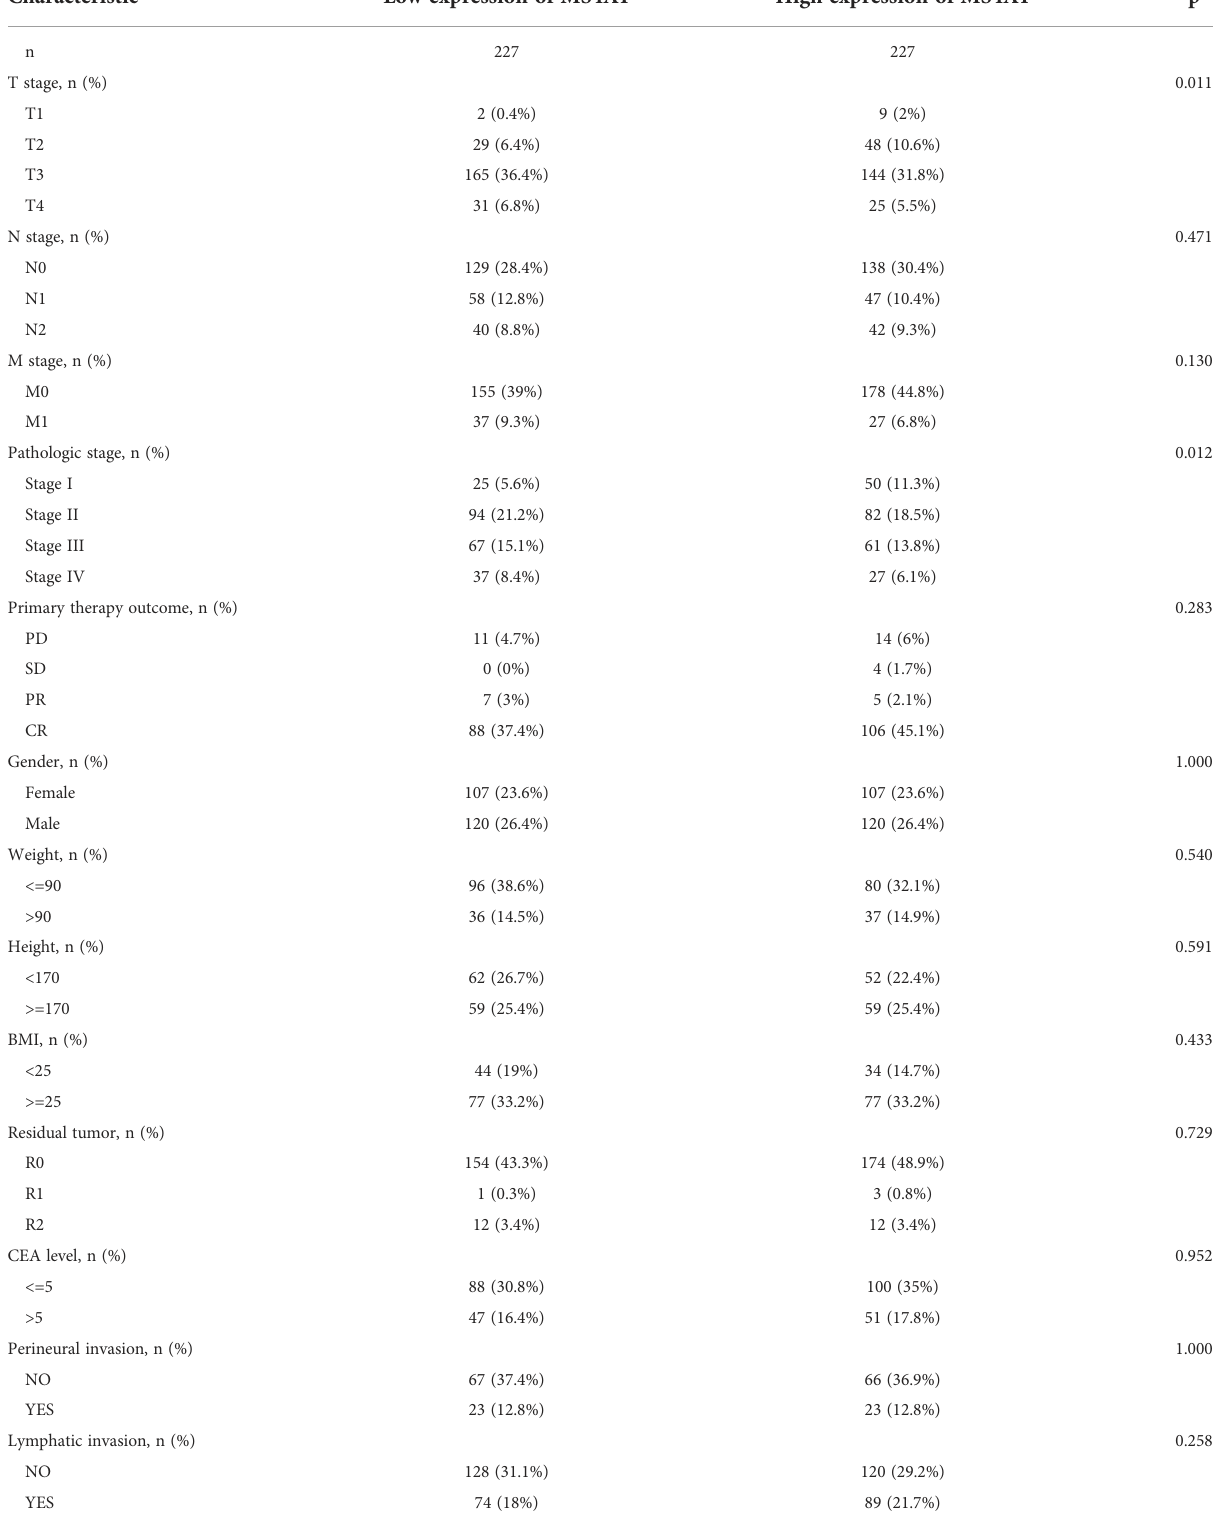
TABLE 1 Analysis of correlation between expression of MS4A1 and